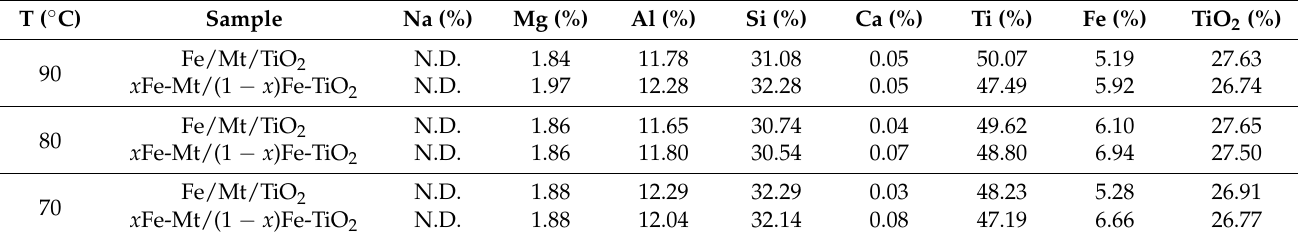
Table 1. Elemental composition of Fe/Mt/TiO 2 and x Fe-Mt/(1 − x )Fe-TiO 2 with different synthesis temperatures (70 ◦ C, 80 ◦ C, and 90 ◦ C) in